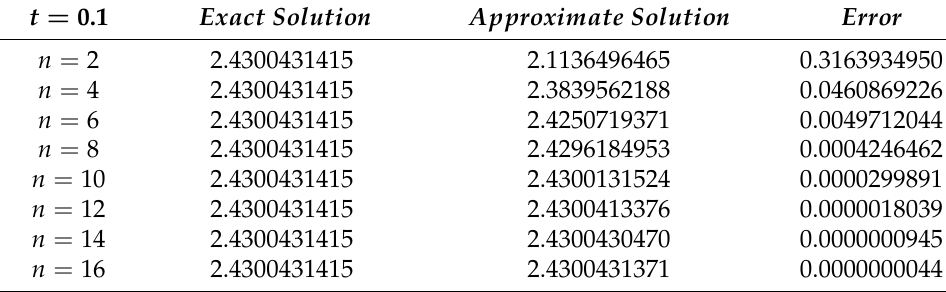
Figure 3. ( a ) Approximate solutions for different values of α ≤ 1. ( b ) Approximate solution for α = 0.5. ( c ) Approximate solution for α = 0.8. Table 1. Error estimates at x = y = 0, t = 0.1 for α =